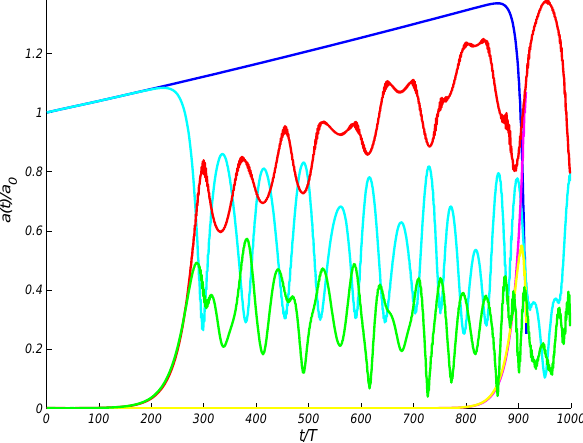
Fig. 1. Time evolution of the normalized amplitudes of the fundamental mode ( k = 5), subharmonic mode ( k = 4) and superharmonic mode ( k = 6) for ( A ,(cid:127)) = ( 4 , 0 . 59 ) . Fundamental mode amplitude ( — ), subharmonic mode amplitude ( — ) and superharmonic mode amplitude ( — ) for an initially unperturbed Stokes’ wave (unseeded case). Fundamental mode amplitude